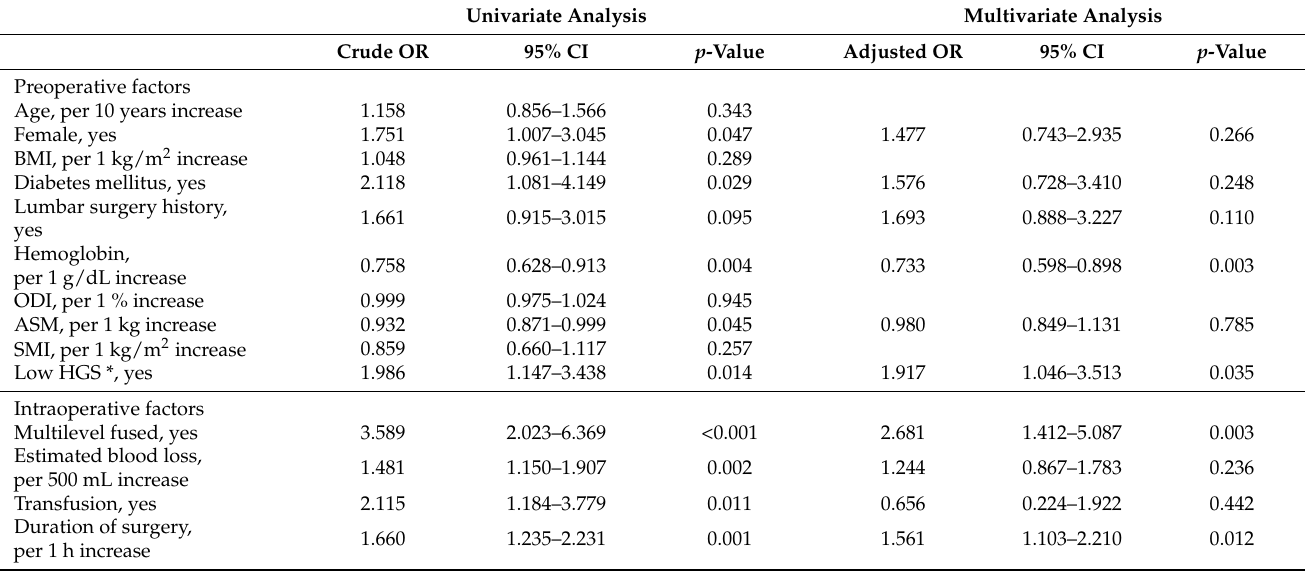
Table 4. Association of patient demographics and perioperative clinical variables with a longer length of hospital stay ( ≥ 10 days) after lumbar fusion surgery in univariate and multivariate logistic regression